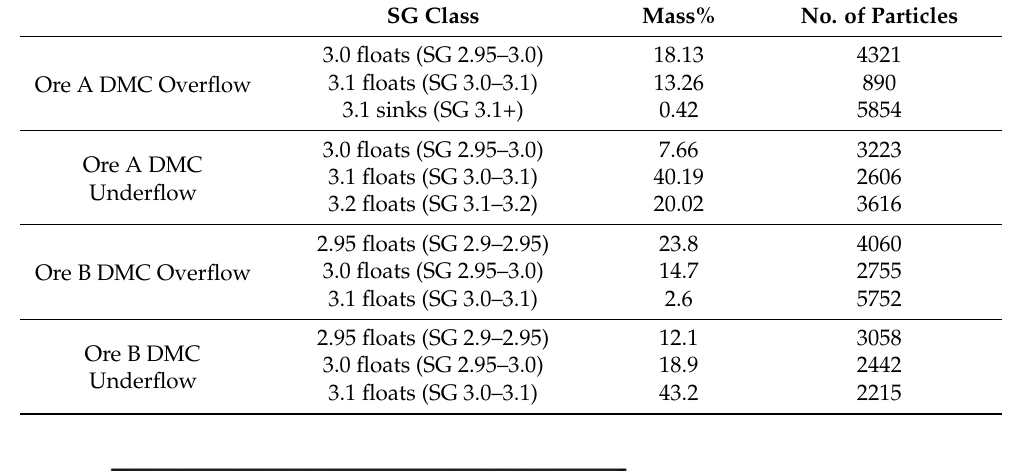
Table 1. List of samples analyzed by QEMSCAN. The mass proportion of the DMC product and the number of particles measured is also given.